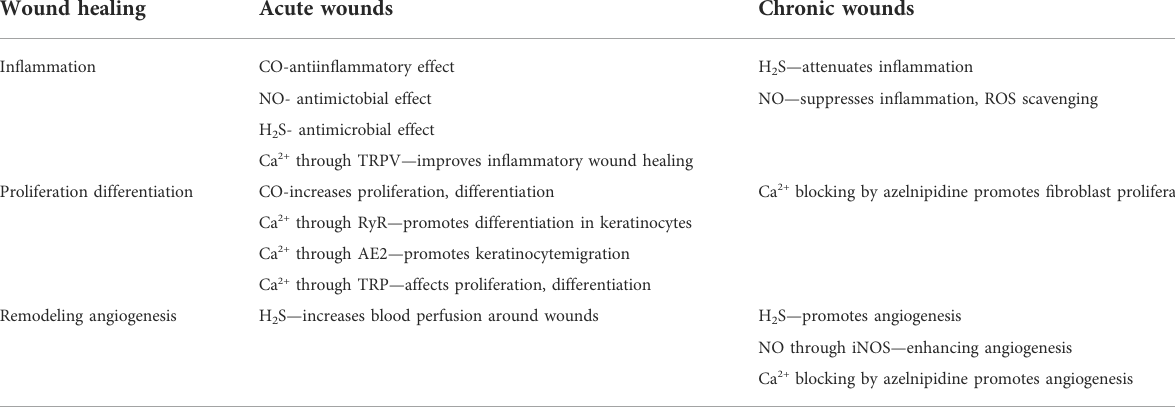
TABLE 2 Involvement of gasotransmitters and calcium transport systems in wound